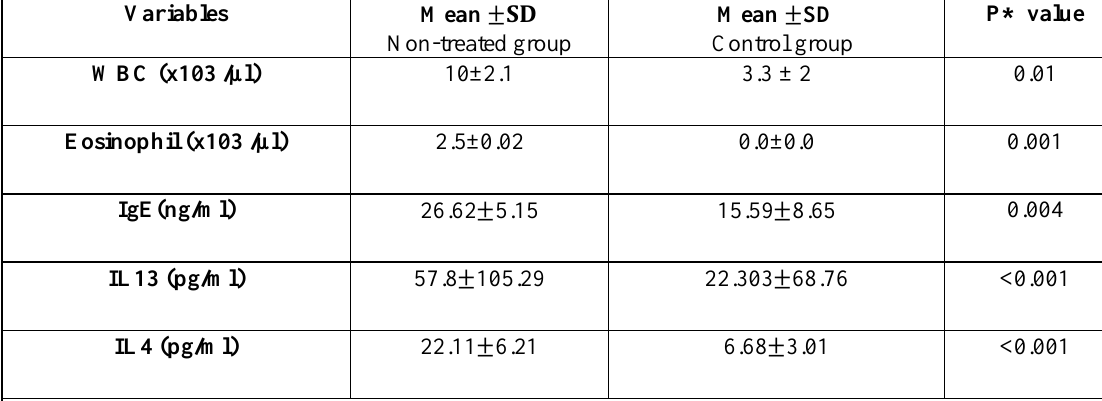
Table 1. Comparison between controls and non-treated atopic dermatitis induced group regarding WBC, Eosinophil, serum IgE, and skin tissue homogenate of IL-13 and IL-4: Variables